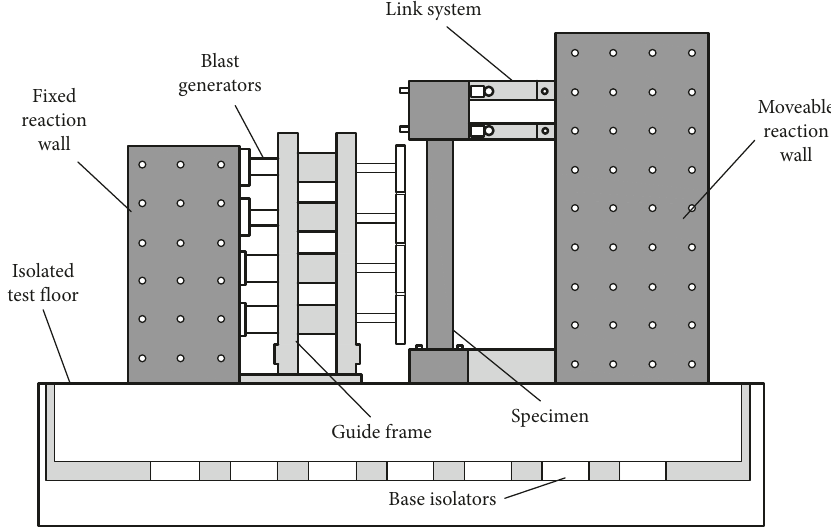
Figure 6: Blast simulator site scheme